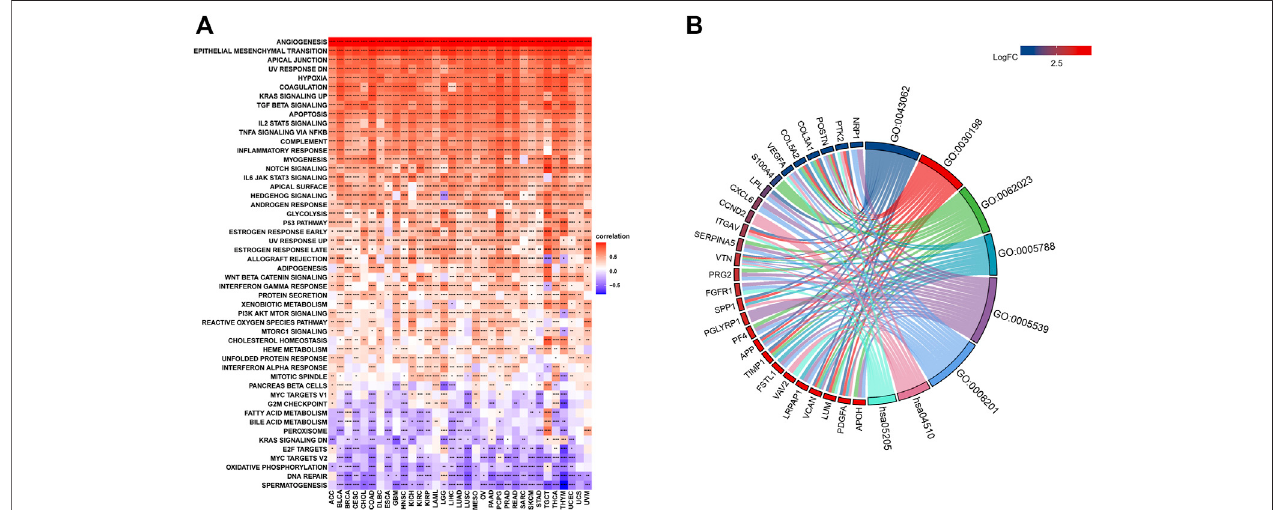
FIGURE3|(A) .GeneSetVariantAnalysis(Red representspositivecorrelations whilebluerepresentsnegativecorrelations.Angiogenesisscoresweresigni fi cantly involved in cancer-related signaling pathways, including Kras signaling, TGF-beta signaling, apoptosis, IL-2 STAT5 signaling, TNF-a signaling via NFK-b, in fl ammatory responses, IL-6 JAK STAT3 signaling, notch signaling, and the P53 pathway. *** denotes p < 0.001, ** denotes p < 0.01, while * denotes p < 0.05). (B) . Enrichment analysisApredominantenrichmentinthePI3K-Aktsignalingpathway,proteoglycansincancer,humanpapillomavirusinfections, andtherelaxinsignalingpathway in BRCA.